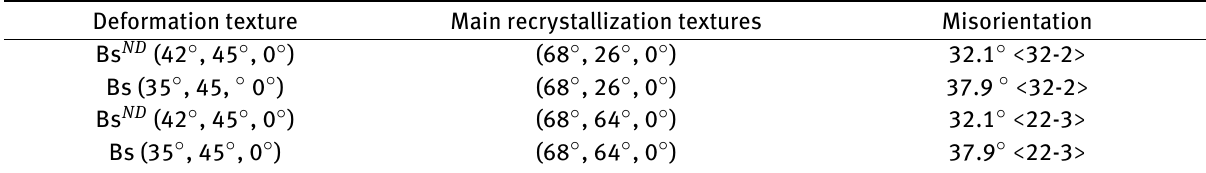
Table 4: Misorientation relationship (angle/axis) between deformation texture and main recrystallization